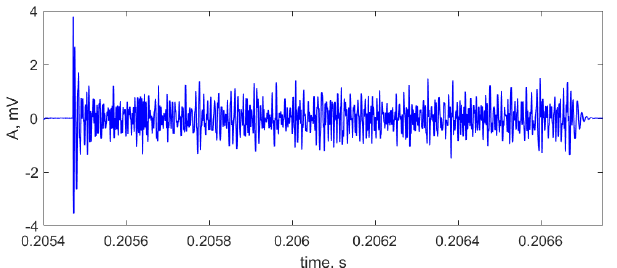
Figure 6. Typical shape of a single.